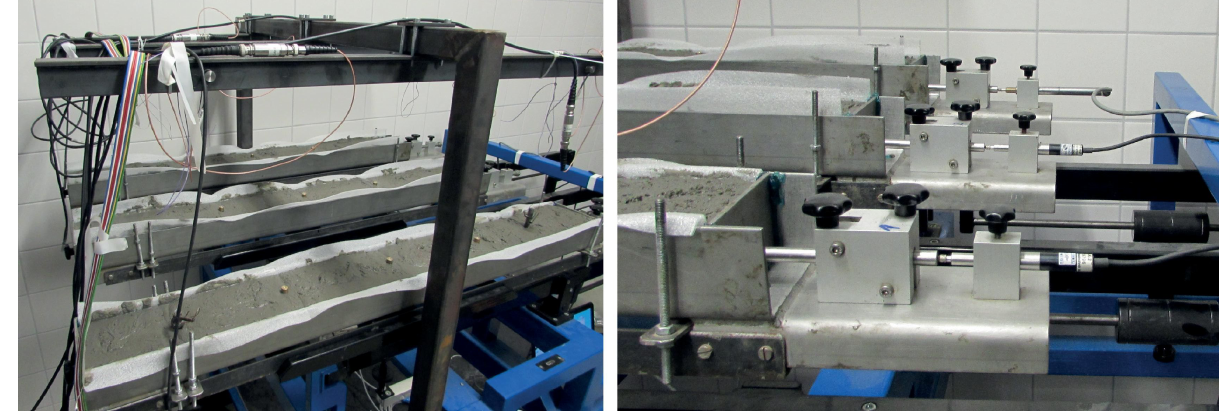
Figure 1. Arrangement of the relative length changes measurement.